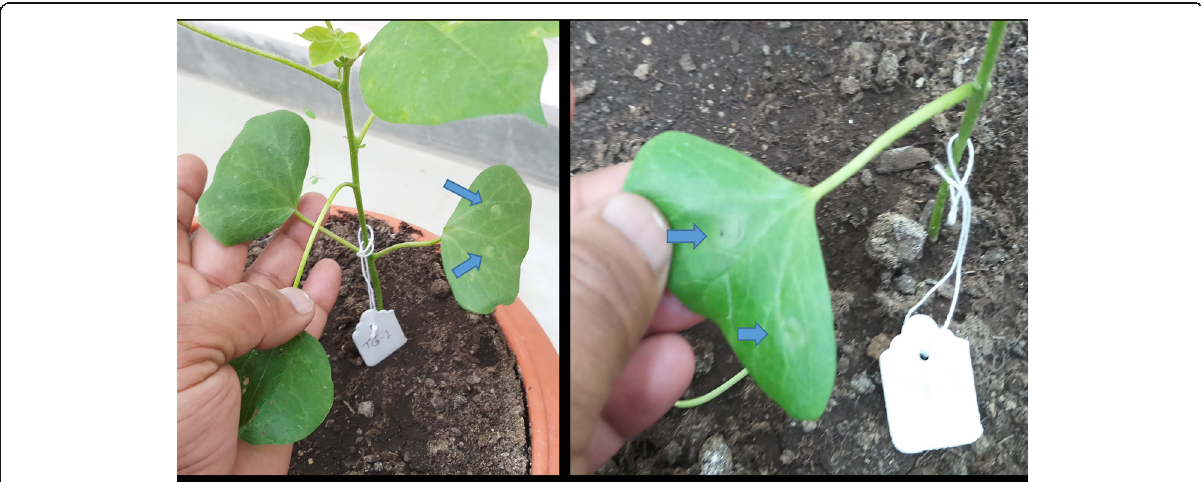
Fig. 2 Sites of Agrobacterium suspension infiltration in cotyledons underside